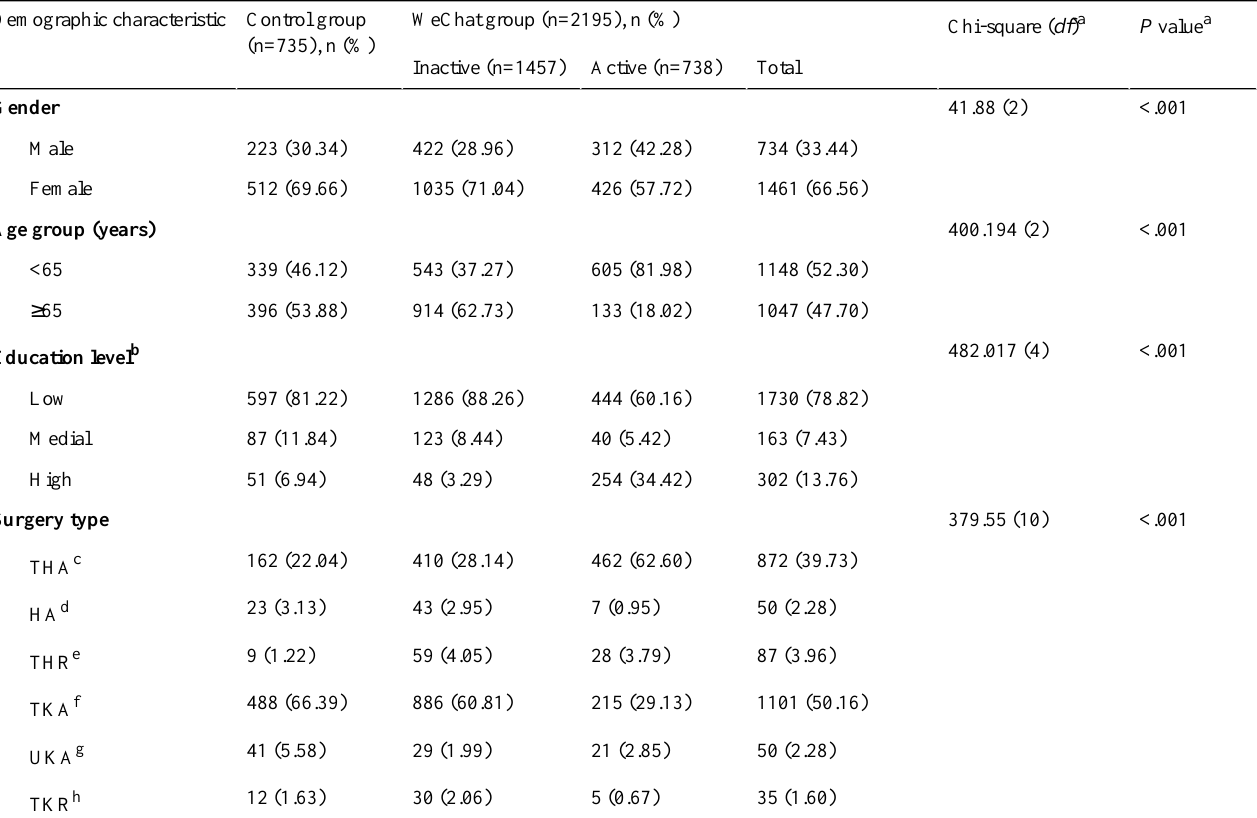
Table 1. Demographic characteristics of the control group and WeChat group